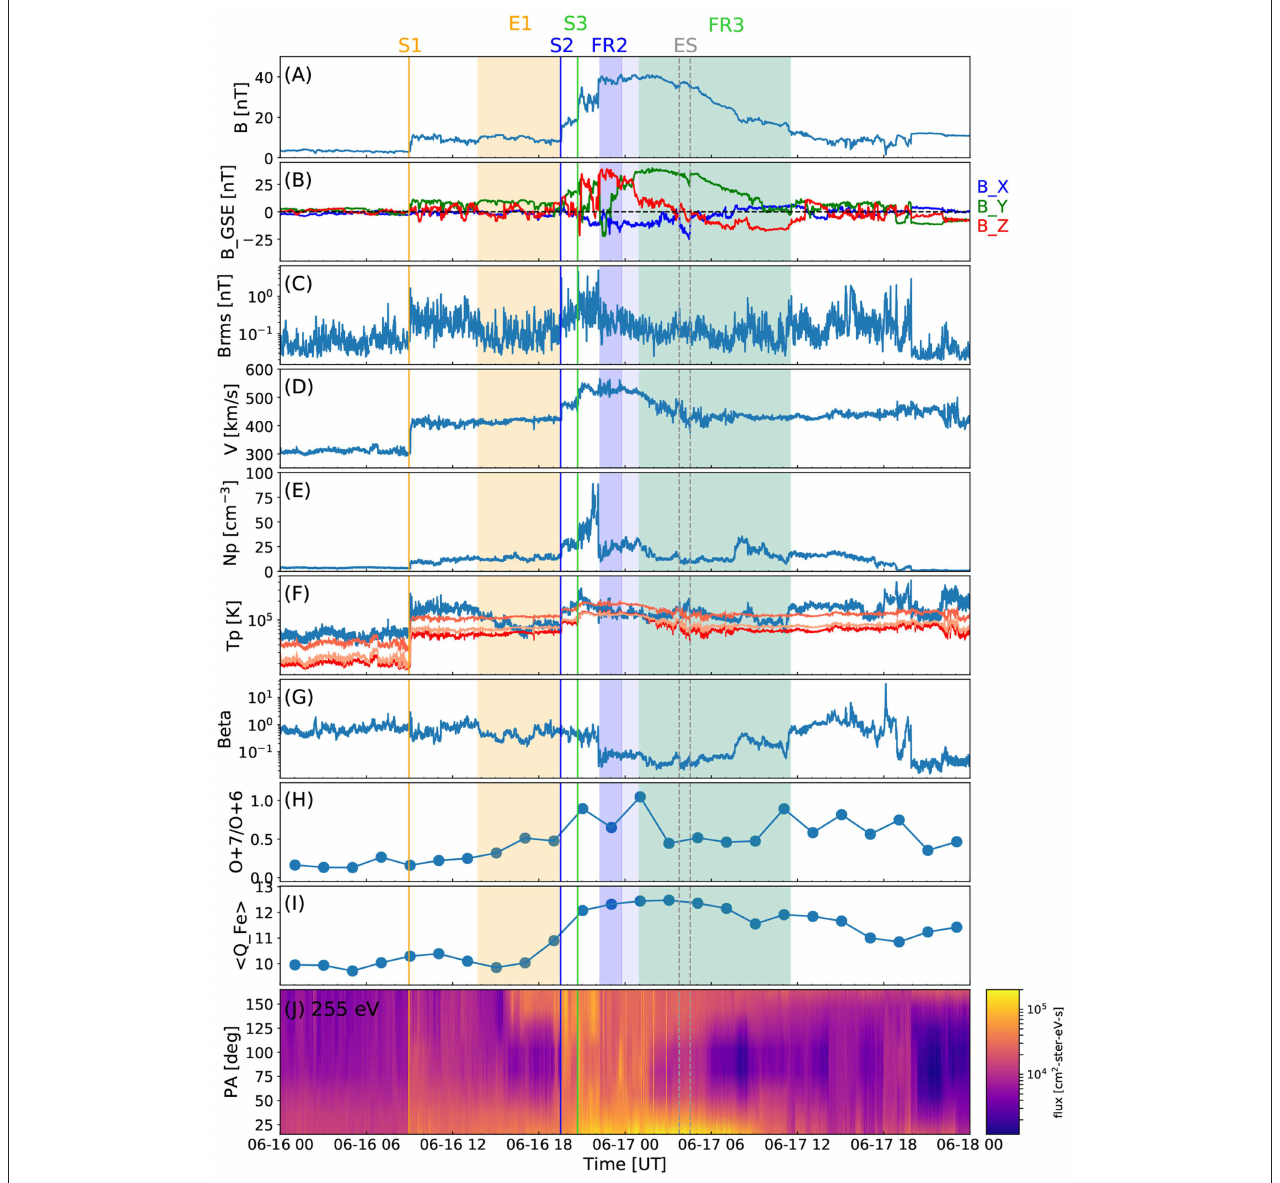
FIGURE 5 | In-situ measurements taken at Earth’s L1 point. The panels show, from top to bottom: (A) magnetic field magnitude, (B) magnetic field components in GSE coordinates (blue: B x , green: B y , red: B z ), (C) root-mean-square magnetic field vector ( B rms ), and solar wind (D) speed, (E) density, (F) temperature (the blue curve is the measured temperature and the red/orange curves indicate the expected temperatures. The red line is from Cane and Richardson (1995), light and dark orange from Elliott et al. (2005) for the rarefactions and compression, respectively; see section 3.3.2 for details), (G) plasma beta, (H) oxygen charge state ratio, (I) average iron charge state, and (J) pitch angle spectrogram of suprathermal 255 eV electrons. The 1 m IMF and 3 s solar wind plasma data are from the Wind spacecraft, while the 2 h charge state data are from the ACE spacecraft. Red solid lines show the interplanetary shocks (S1, S2, and S3). Flux rope intervals are indicated by the dark blue and green shaded regions for FR2 and FR3, respectively; though still associated with the CME2 ejecta, the pale blue shaded region is identified as not being part of FR2. The embedded substructure (ES) is bounded by a pair of dashed gray lines.